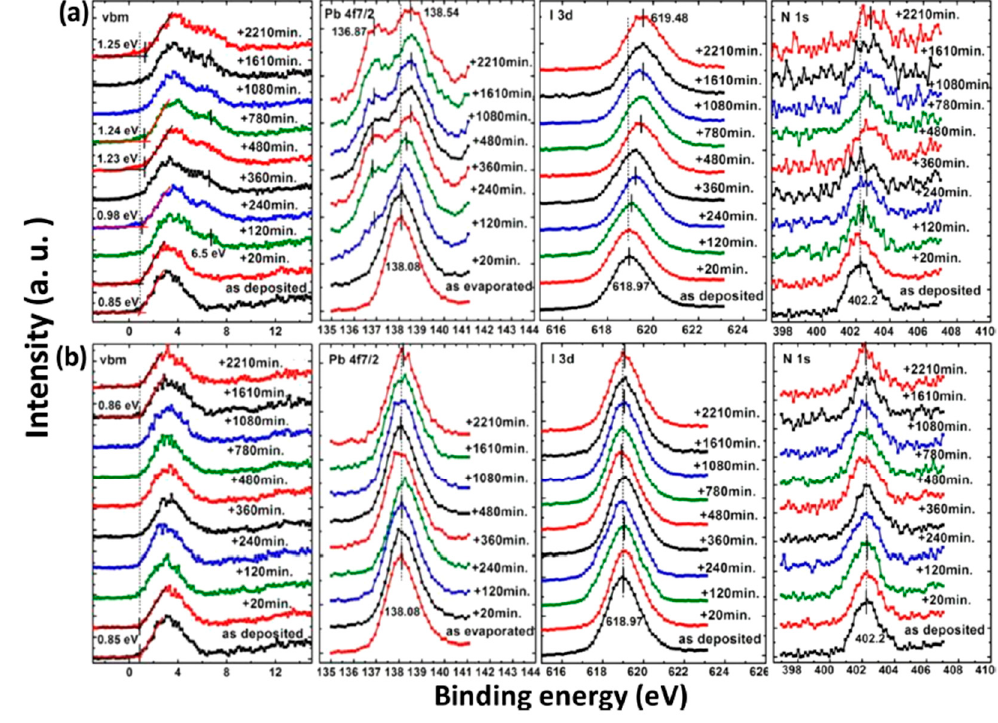
Figure 5. XPS spectra of co-evaporated MAPbI 3 thin film at ( a ) laser irradiated and ( b ) nonirradiated positions. From Ref. [54] with permission.